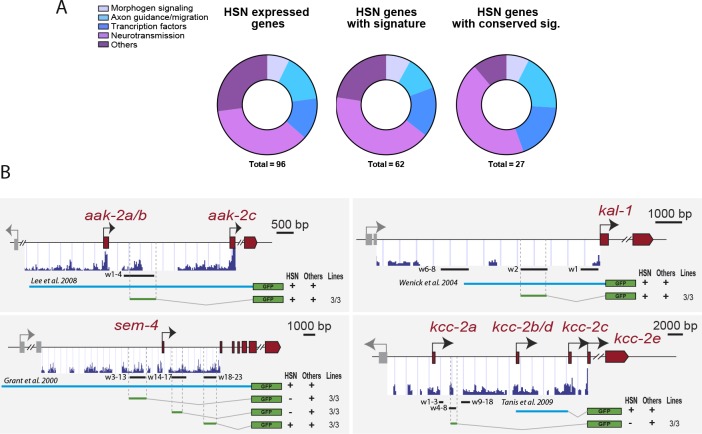
HSN regulatory signature distribution in HSN expressed genes.(A) No significant difference was found in the functional distribution of all HSN expressed genes compared tothe subset og genes with HSN regulatory signature or HSN expressed genes with conserved signature (chi-squared test computing p-values by Monte Carlo simulation p-value=0.59). (B) Reporter analysis to test functionality of HSN signature windows in HSN expressed genes. Black lines represent the coordinates covered by bioinformatically predicted HSN signature windows (indicated by w and a number). Light blue lines indicate the published reporter construct(PMID:18408008, PMID: 15177025, PMID: 10926783 and PMID:19675228) . Green lines mark the region used in our analysis. Dark blue bar profiles represent sequence conservation in C. briggsae, C. brenneri, C. remanei and C. japonica. See Figure 7—source data 1 for a list of all reporters and raw scoring data.